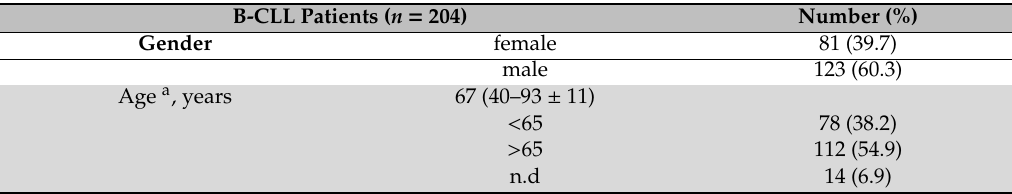
Table 1. Clinical and molecular characteristics of -cell chronic lymphocytic leukemia (B-CLL)